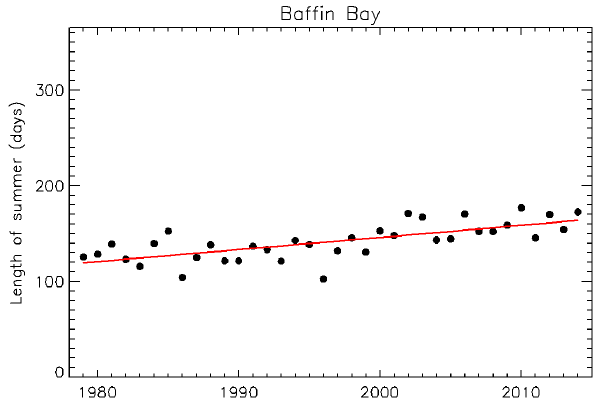
Figure 4. Dates of sea-ice retreat (red) and sea-ice advance (blue) in Baffin Bay (all depths) for 1979–2014. The red and blue lines are least-squares fits. The vertical green lines indicate the time interval between retreat and advance (i.e., length of summer season). See Table 3 for trends. See Fig. S2 for similar plots for other regions.